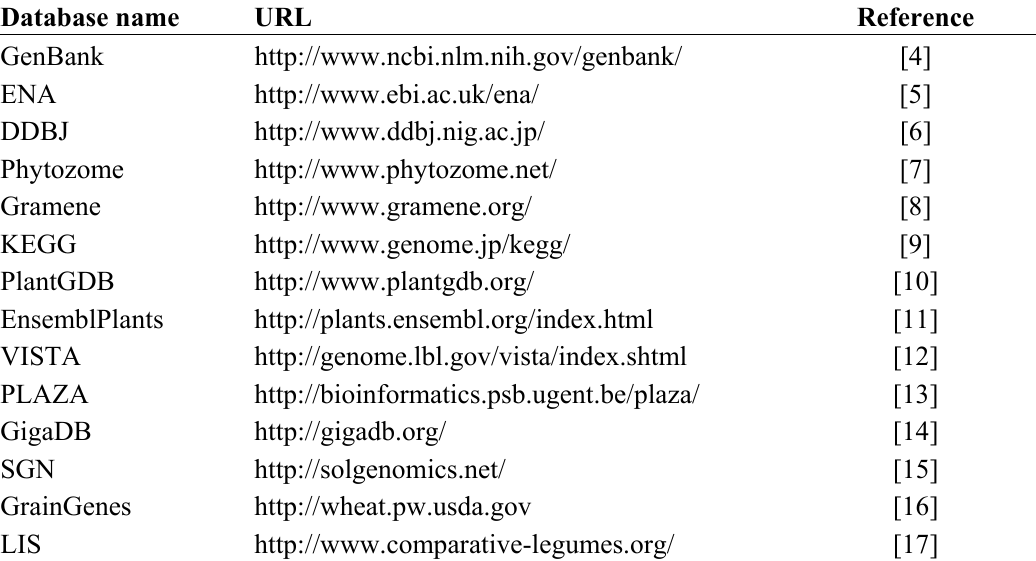
Table 1. Example of some commonly used